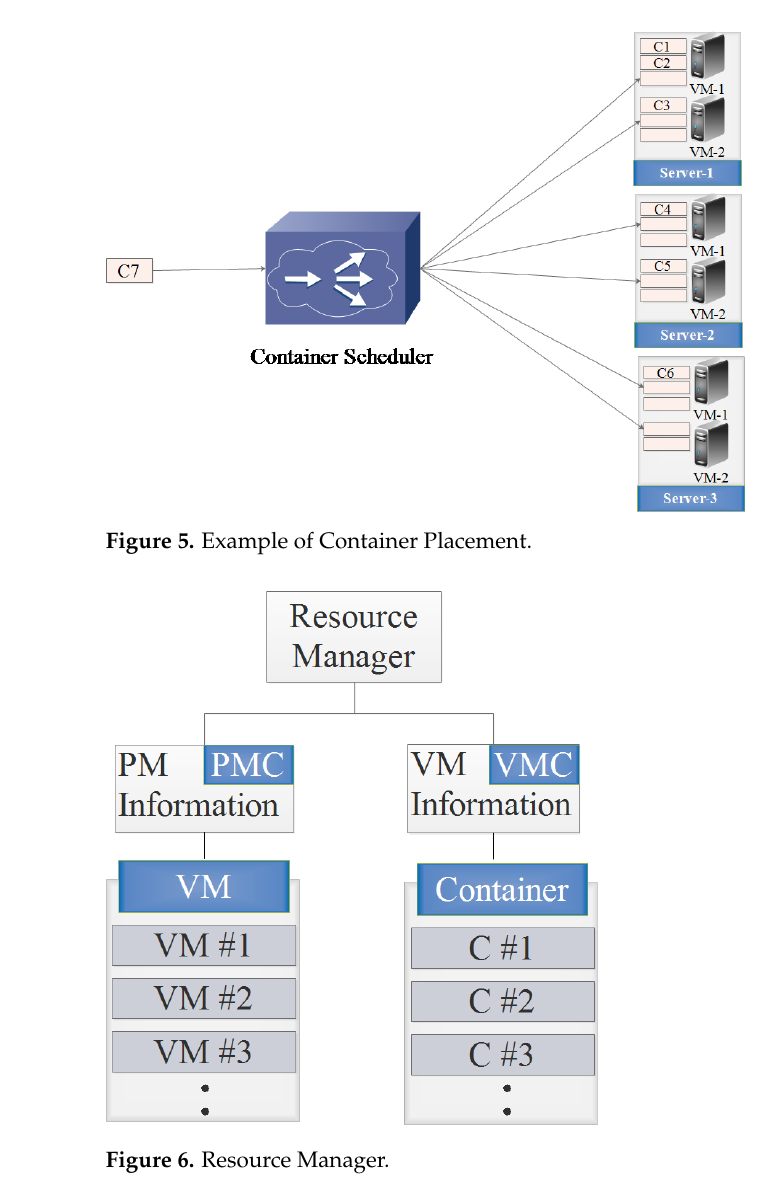
Figure 6. Resource